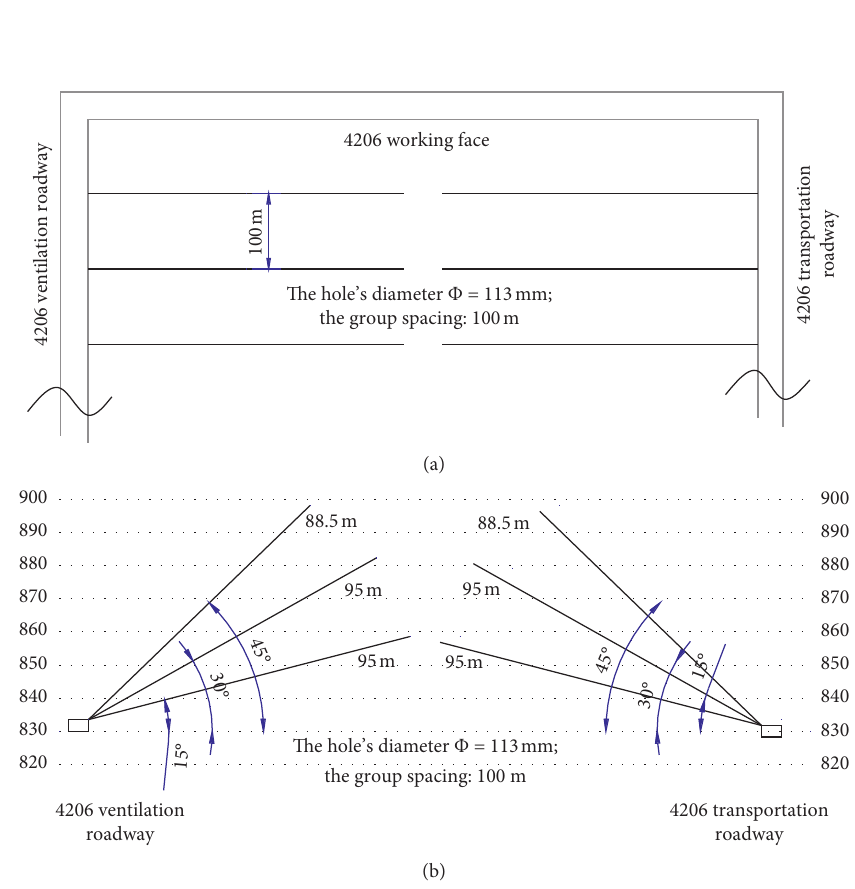
Figure 10: Layout of presplitting blasting holes in roof. (a) Plan. (b)